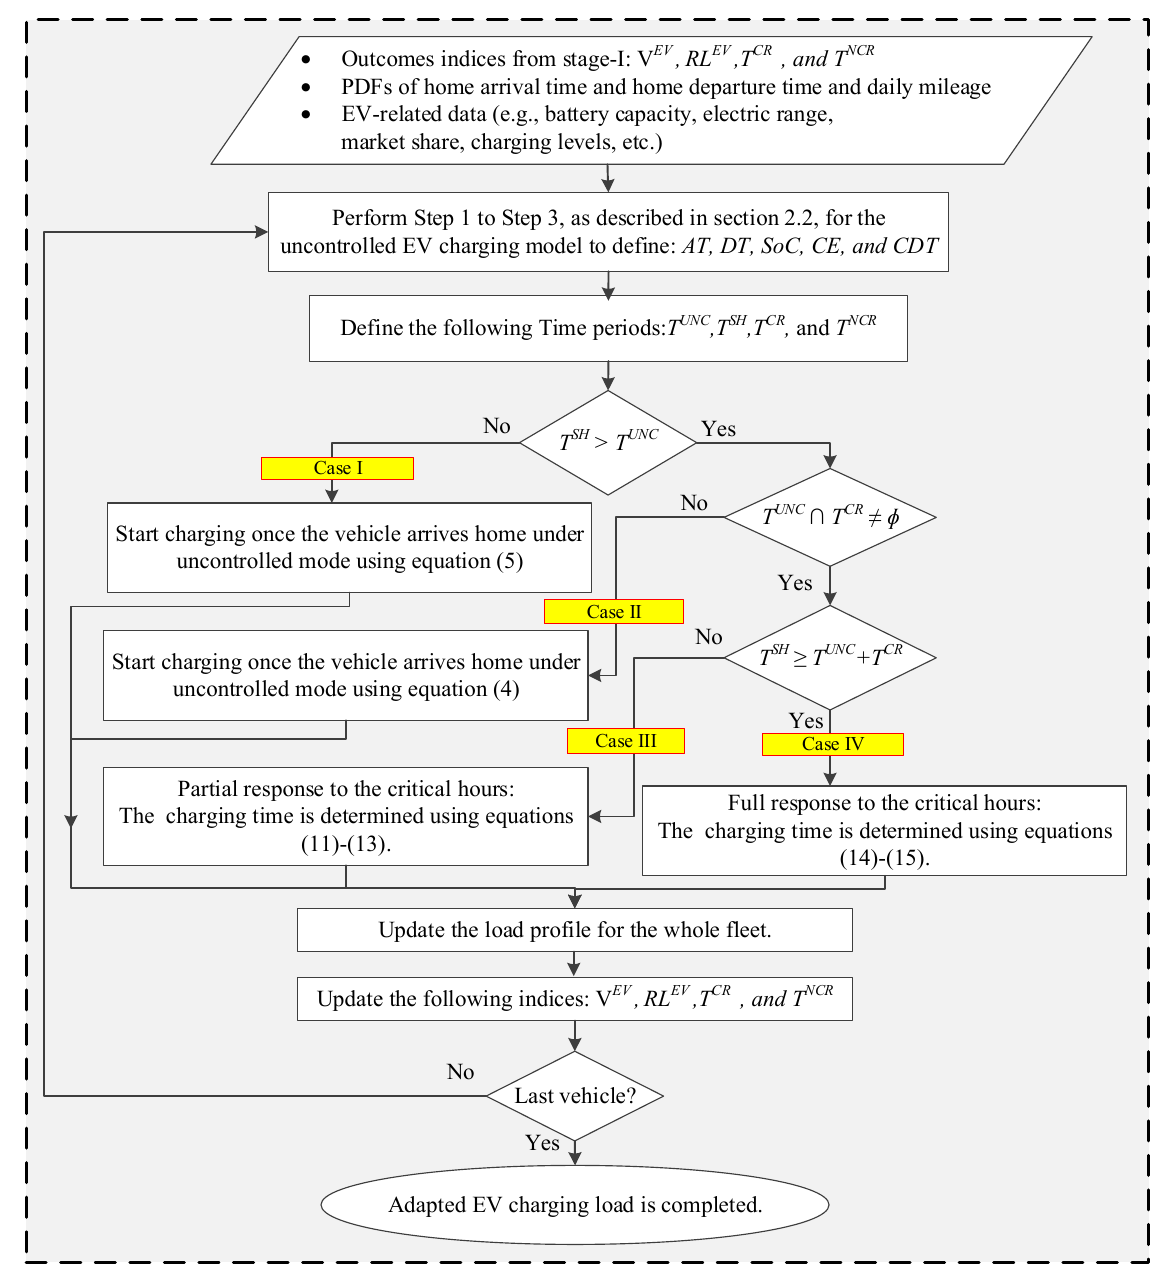
Figure 7. EV load model with response to the system critical hours.